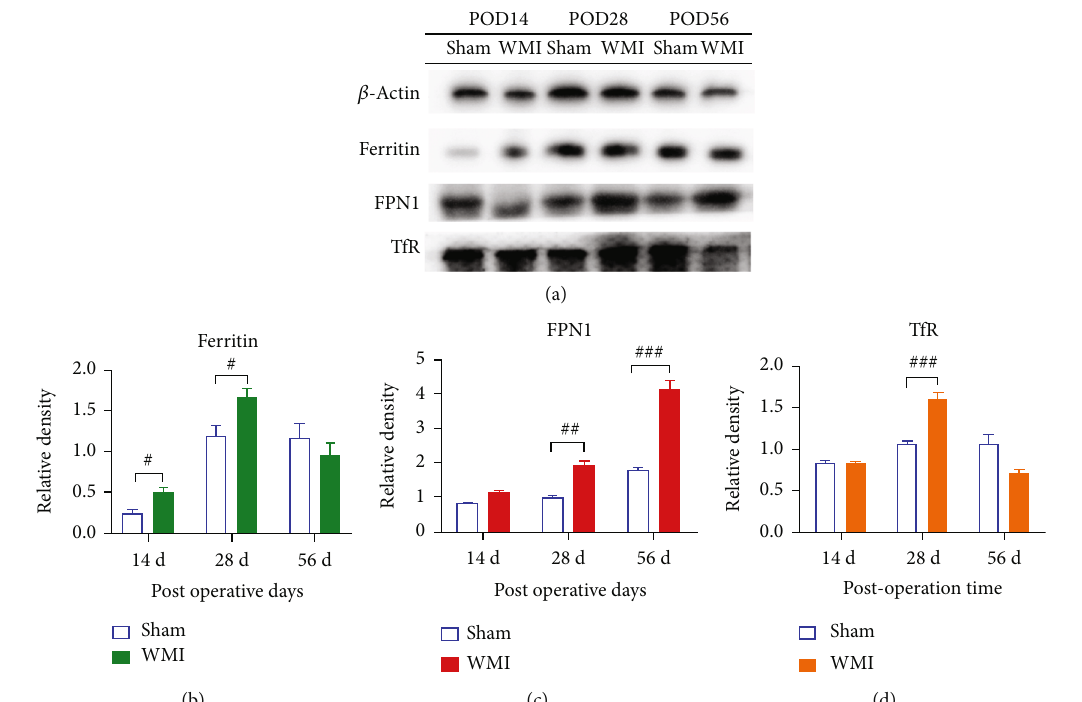
Figure 3: E ff ect of hypoxia-ischemia on the expression of ferritin, FPN1, and TfR in brain tissue on PODs 14, 28, and 56. (a) Bands of Western blots from brain tissue. (b – d) Relative protein expression of ferritin, FPN1, and TfR ( # p < 0 : 05 , ## p < 0 : 01 , and ### p < 0 : 01 vs. sham group, n = 4